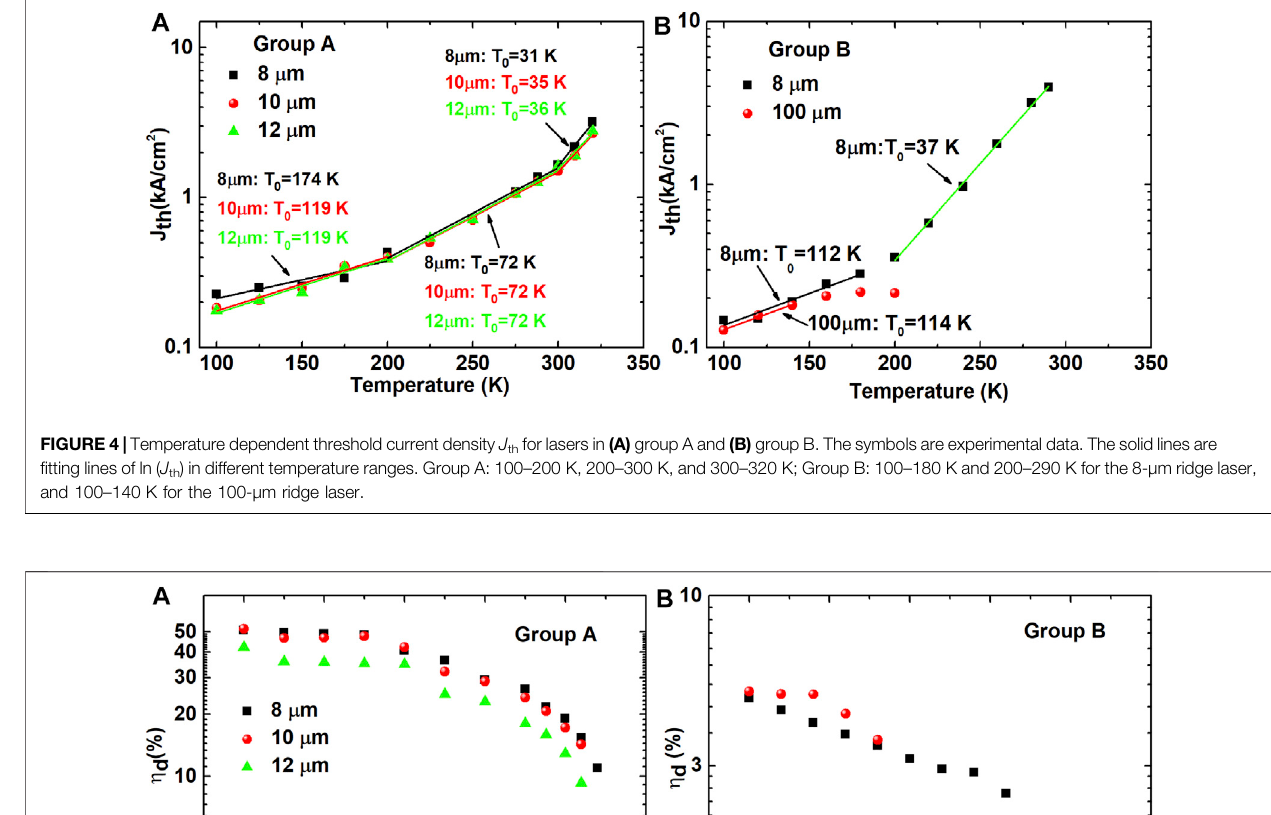
Frontiers in Materials |